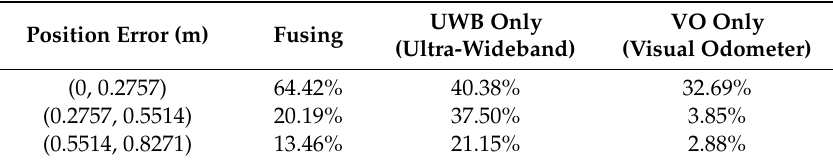
Table 3. Percentage of location points in the y direction.